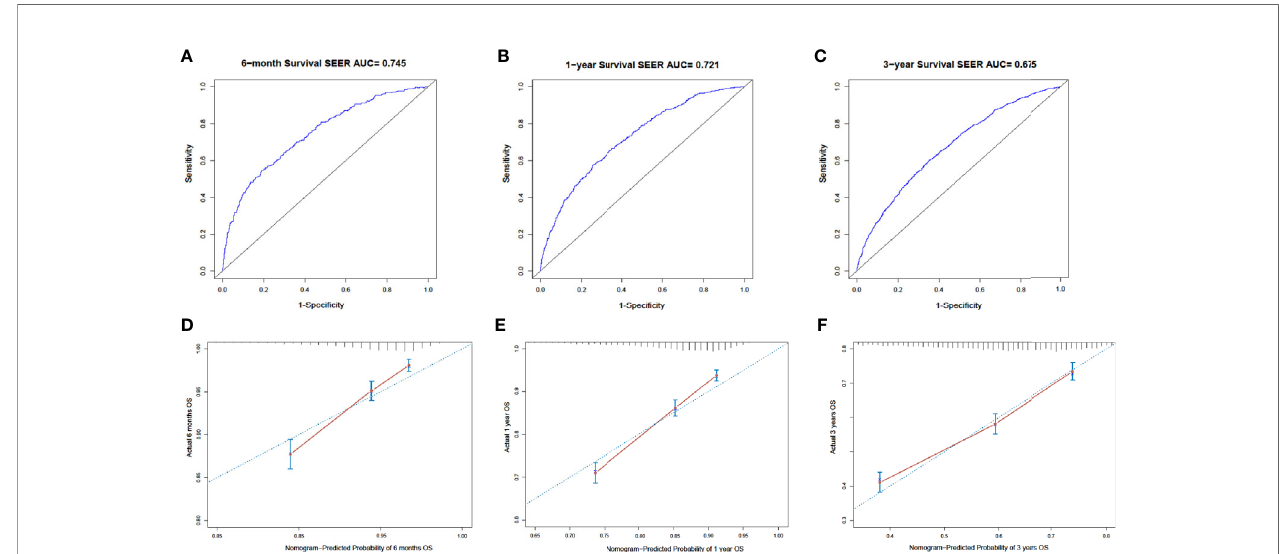
FIGURE 3 | Nomogram with ROC analyses and calibration curves for training cohort. (A – C) Discrimination of 6-month (p < 0.01) (A) , 1-year (p < 0.01) (B) , and 3-year (p < 0.01) (C) OS in training cohort with ROC curves. (D – F) Calibration curves for 6-month (D) , 1-year, (E) and 3-year (F) OS from model. Y-axis and x-axis indicate actual survival probability and predicated survival probability, respectively. Blue dotted line indicates prediction accordance with actuality. Error bars show 95%